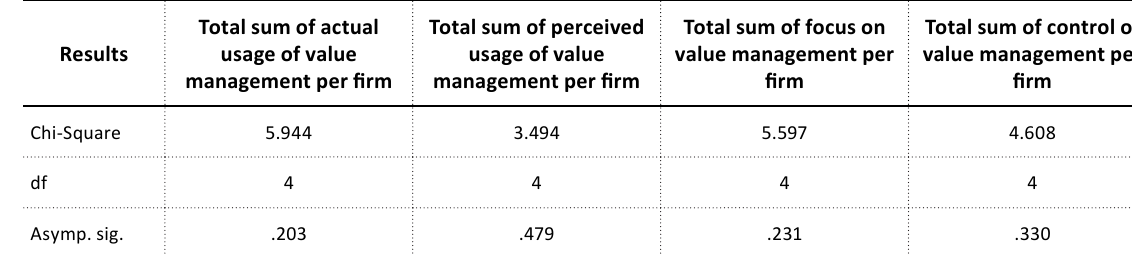
Table 5. Kruskal-Wallis H result on group